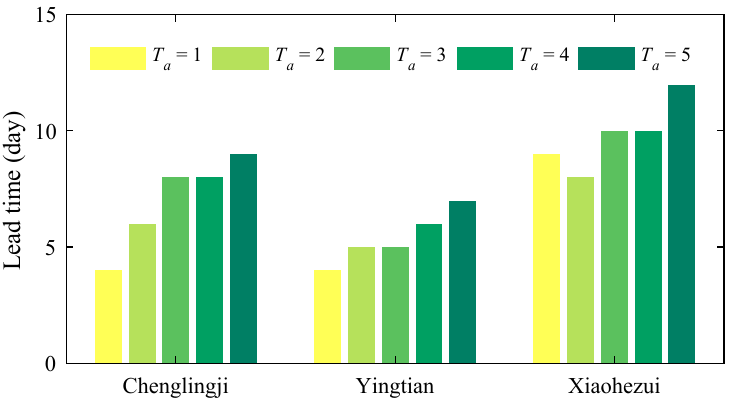
Figure 16. Lead time of SVR+UKF for Dongting Lake water level prediction.